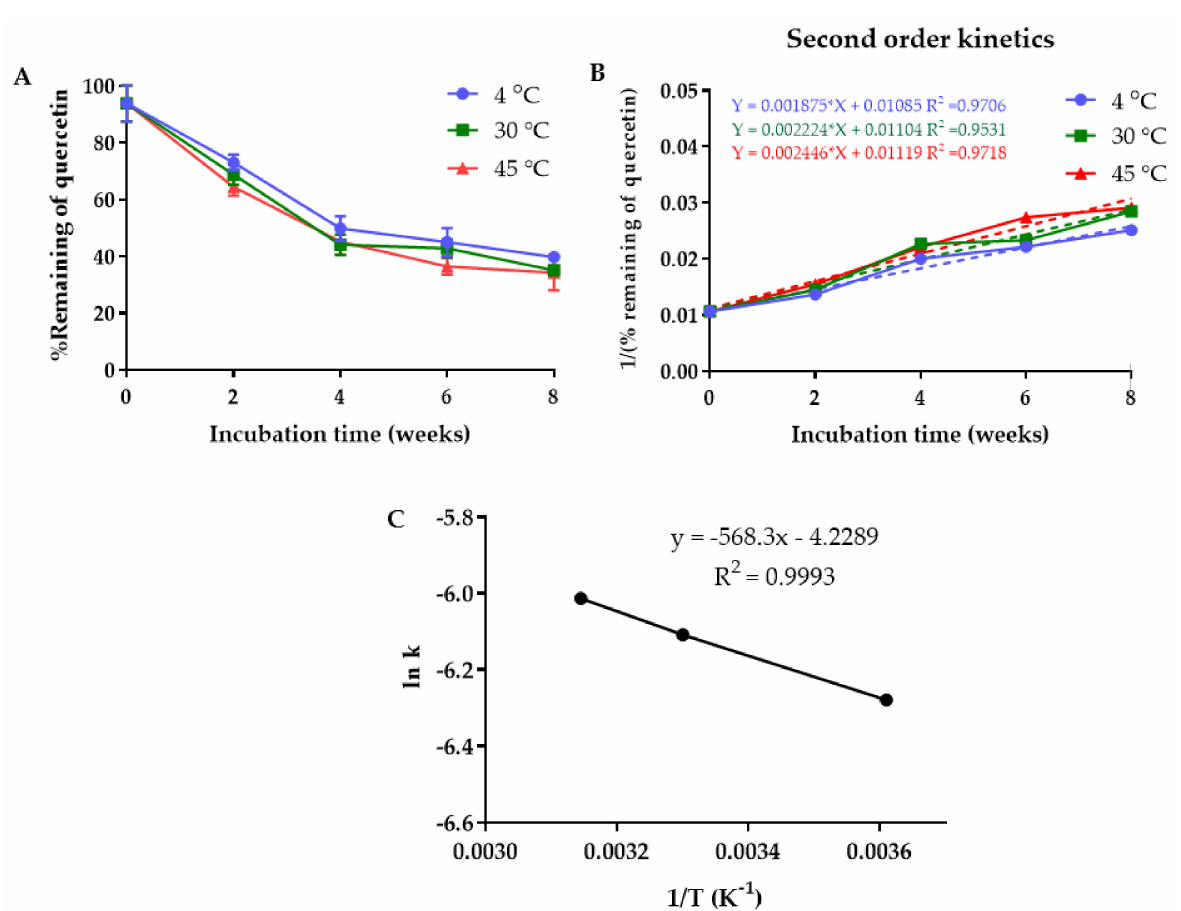
Figure 6. ( A ) Percentage remaining of the quercetin in PLGA NPs after storage at 4 ◦ C, 30 ◦ C, and 45 ◦ C for 8 weeks. ( B ) Second-order kinetics model of the quercetin degradation. ( C ) Arrhenius plot for the quercetin in PLGA NPs